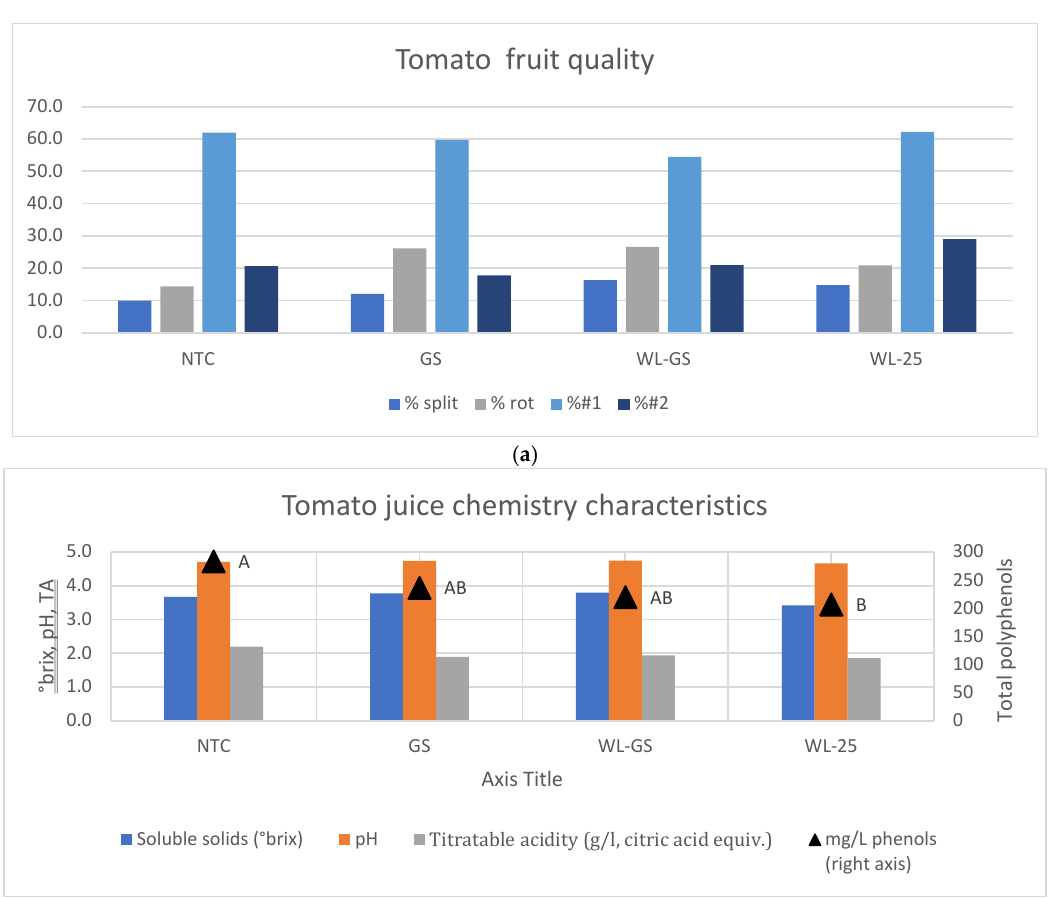
different at α = 0.05 using Tukey’s adjustment for multiple comparisons. x Overall p -value for initial one-way ANOVA f-test.